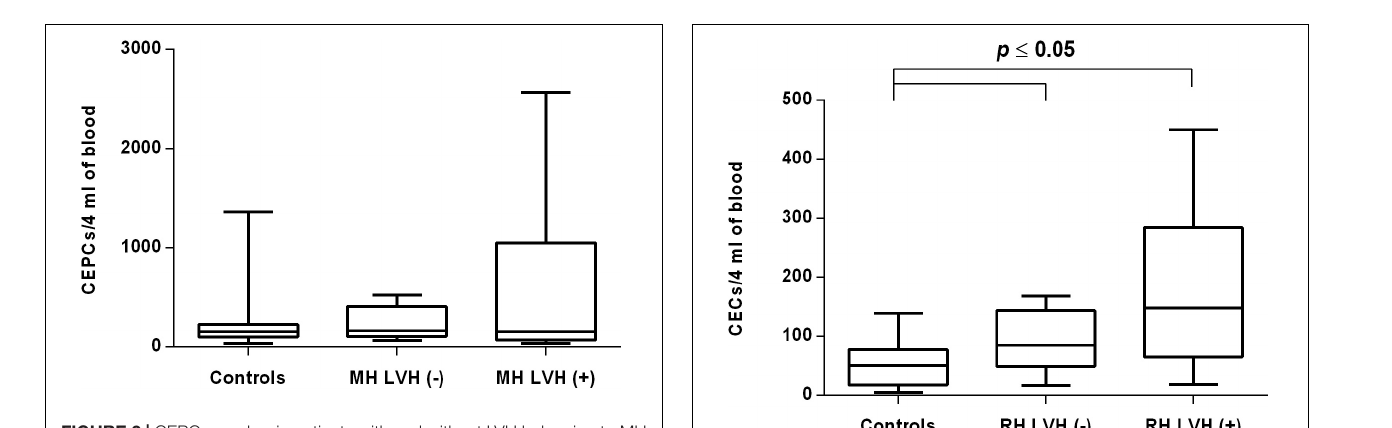
FIGURE 2 | CEPCs number in patients with and without LVH belonging to MH group. Box and whisker plots show median (central line), upper and lower quartiles (box) and range excluding outliers (whiskers). Data were analyzed using Kruskal-Wallis test followed by the Dunn’s multiple comparison test. P ≤ 0.05 was considered statistically significant.